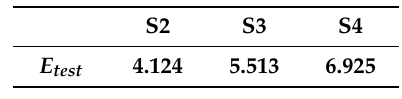
Table 3. Test errors of the three RVFLNN